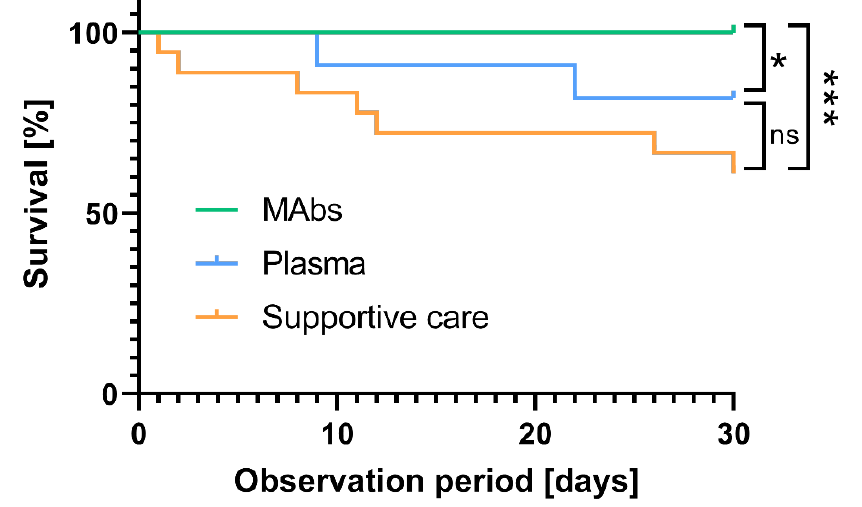
Figure 2. Overall survival of COVID-19 patients received either mAbs, convalescent plasma or supportive care. The survival of the patients was monitored for 30 days after initiating the treatment. Differences in the overall survival at day 30 were calculated using the Chi-square test. Comparisons were considered significant at * p < 0.05 and *** p < 0.001.